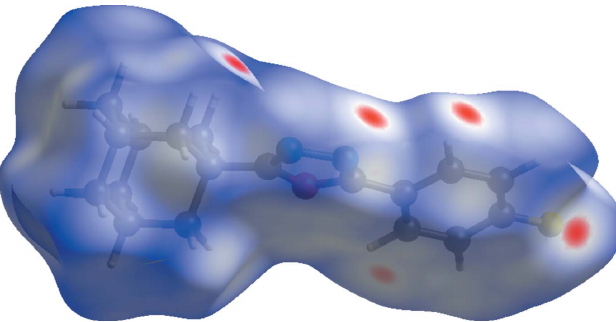
Figure 6 Aview of the Hirshfeld surface mapped over d norm for compound (I) over the range (cid:5) 0.138 to 1.364 arbitrary units.